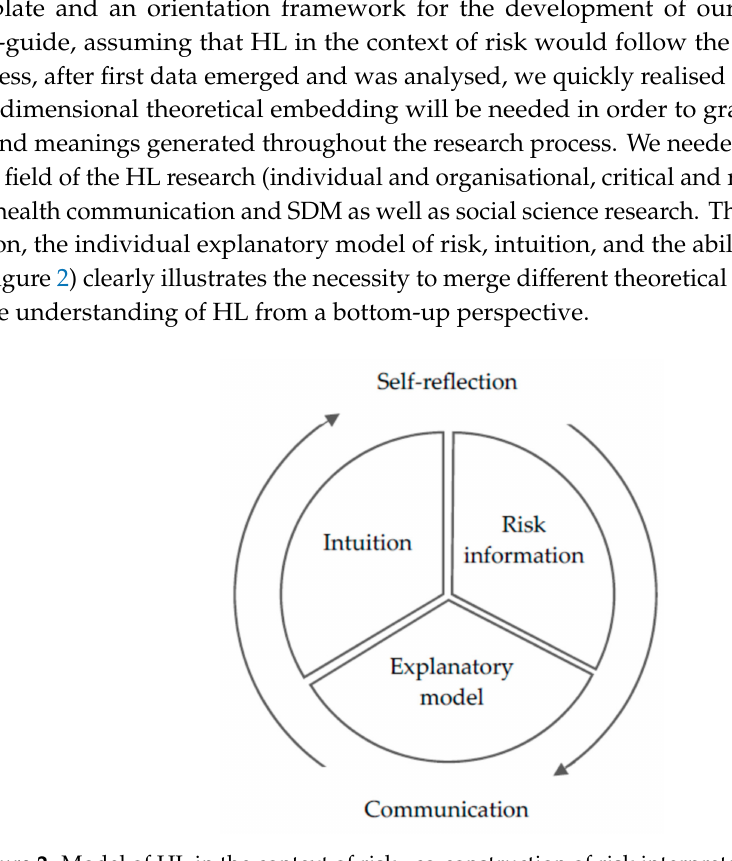
Figure 2. Model of HL in the context of risk– co-construction of risk interpretation and